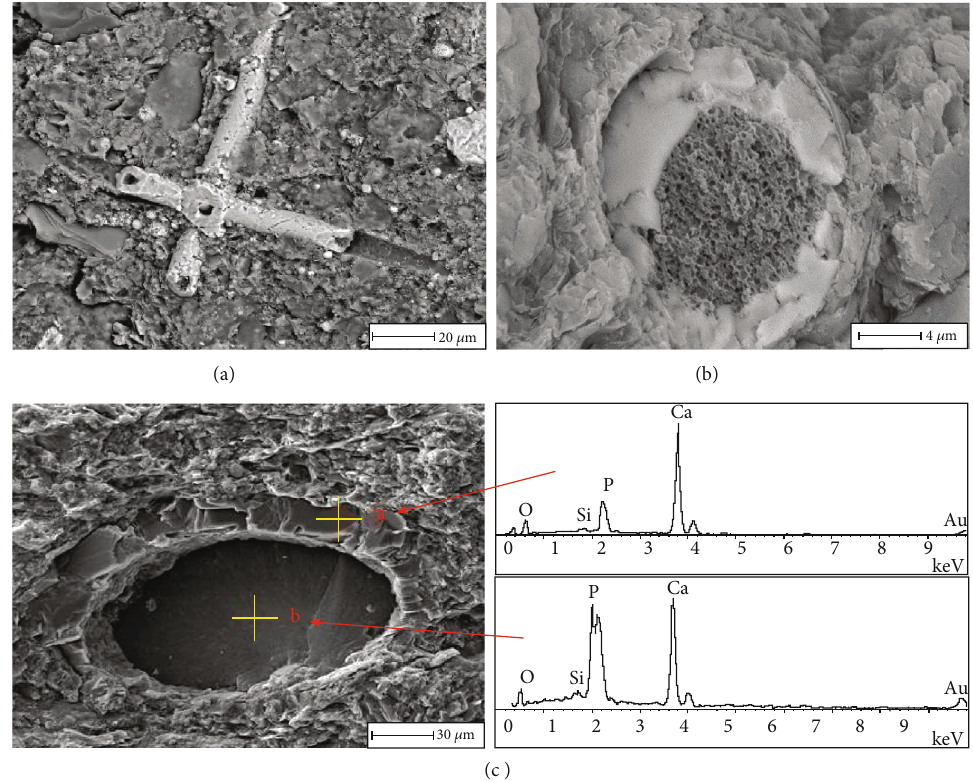
Figure 7: Biodetritus morphology photograph and energy spectrum of the Wufeng-Longmaxi Formation shale in the southeast Sichuan Basin. (a) Sponge spicule. (b) Sponge spicule (cross section). (c) Biodetritus with calcium and phosphorus.